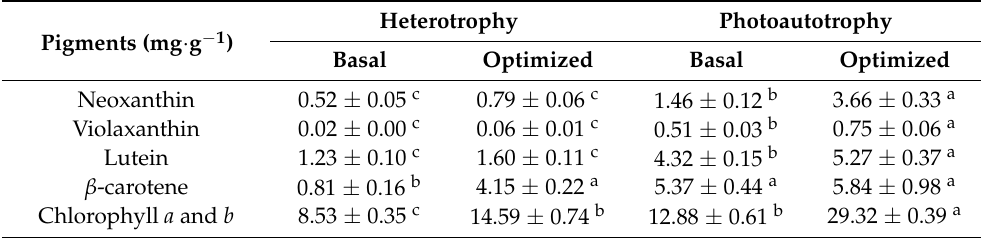
Table 10. Pigment profile in mg · g − 1 of Chlorococcum amblystomatis biomass grown with hetero- and photoautotrophic basal and optimized heterotrophic media. Different letters indicate significant differences between media. Values are given as mean ± standard deviation ( n =